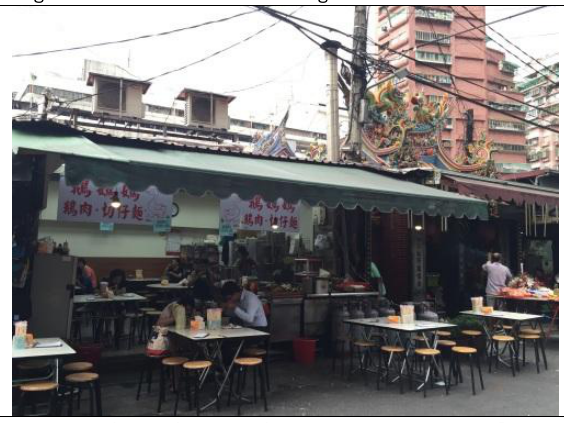
Figure4. The cooking vendors next to Jiying Temple use the fire and fuel